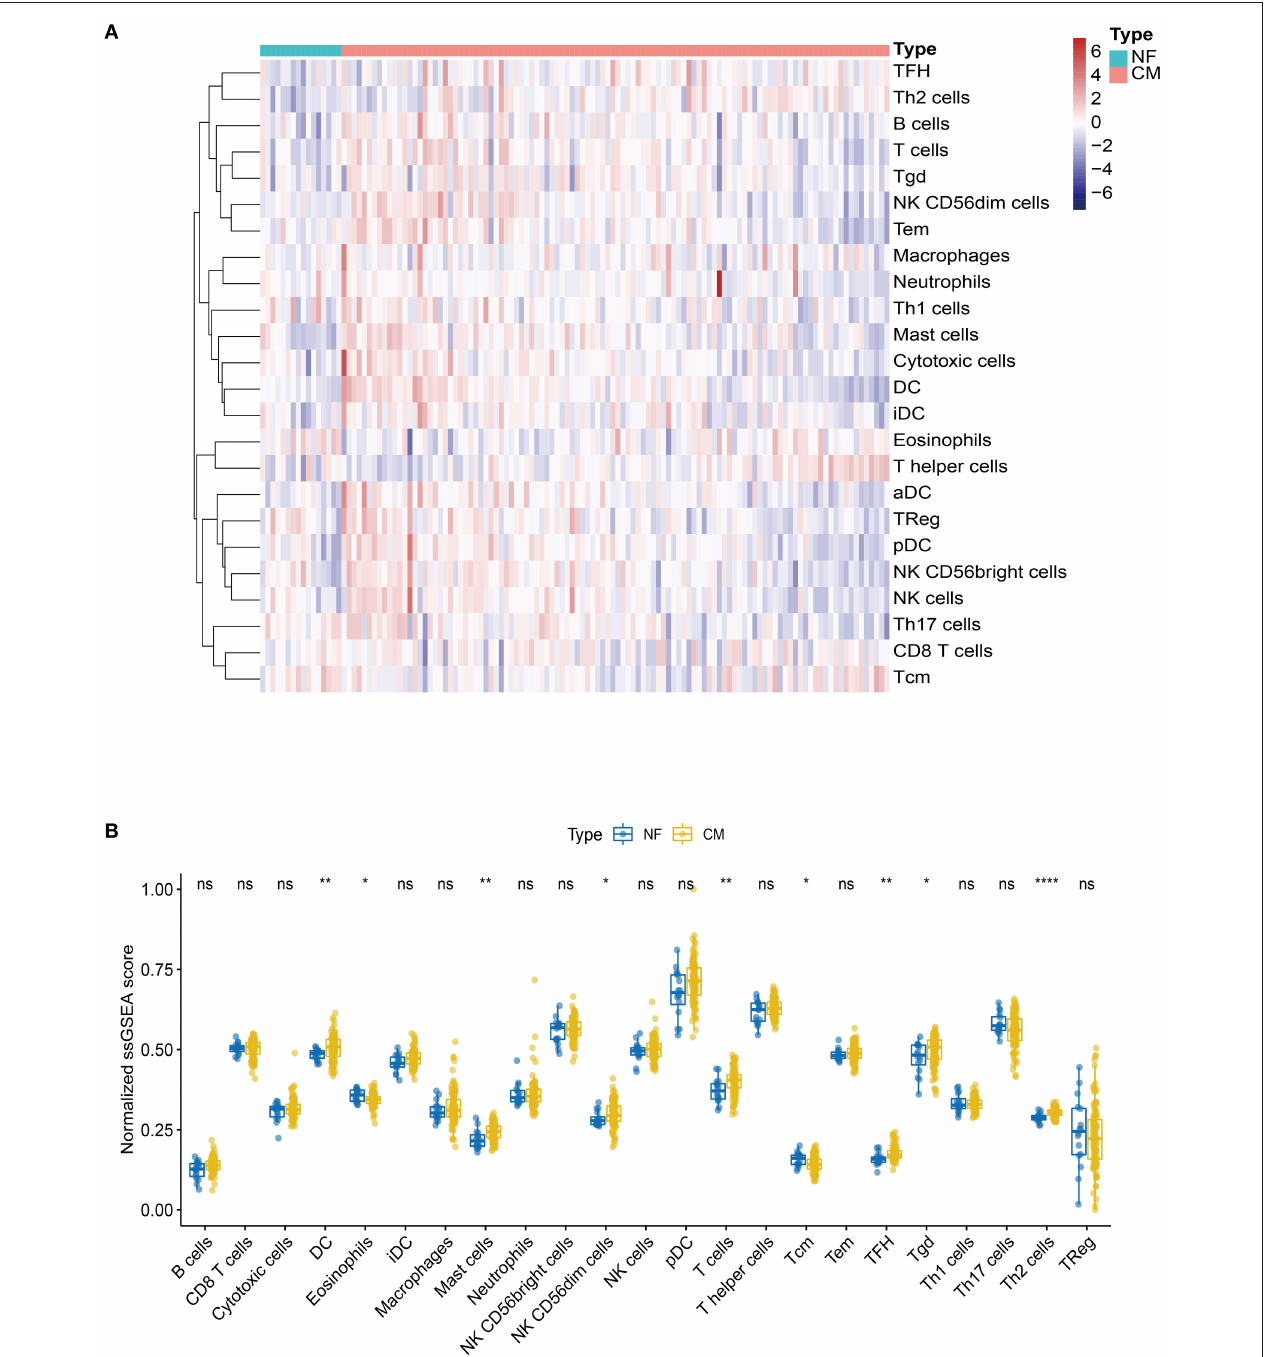
FIGURE 2 | Landscape of the immune infiltration in NF and CM samples. (A) Heatmap of the immune infiltration profiles of NF and CM samples analyzed by ssGSEA score-based method. (B) Comparison of immune cell infiltration between NF and CM samples. * p < 0.05, ** p < 0.01, **** p < 0.001.